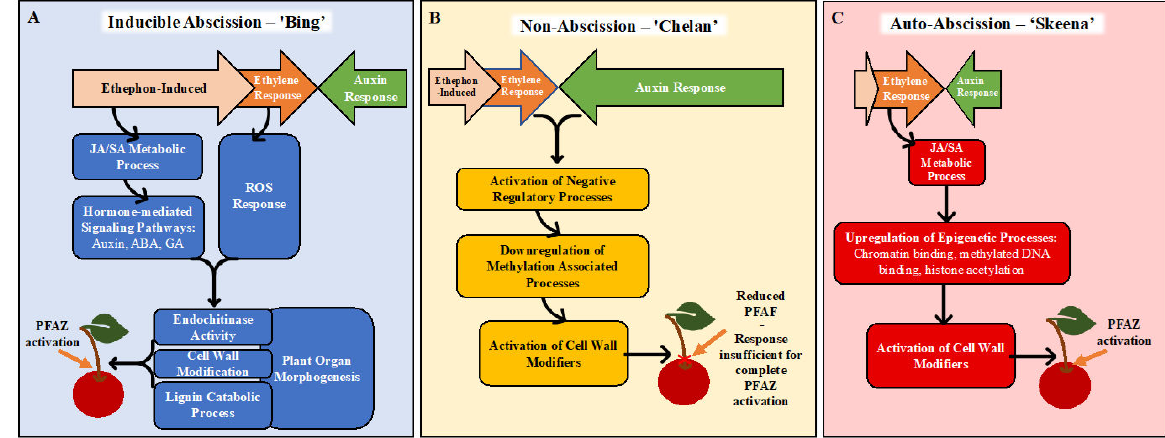
Figure 7. Hypothetical models for abscission, based on gene expression and gene ontology (GO) enrichment results following ethephon application of ‘Bing’, ‘Chelan’, and ‘Skeena’ sweet cherry. In ‘Bing’ ( A ), ethephon offsets the balance between ethylene and auxin in favor of ethylene. This triggers endogenous ethylene-responses that stimulates JA- and SA-mediated signaling, additional hormone-mediated signaling pathways and reactive oxygen species (ROS) responses. Together, these ethylene-induced signaling pathways activate downstream processes associated with morphological changes at the PFAZ, including chitin metabolism, cell wall modification, plant organ morphogenesis, and lignin biosynthesis and deposition. The culmination of these events ultimately facilitates the mechanical separation of the fruit at the PFAZ. In ‘Chelan’ ( B ), the components required for inducible abscission seem to be partially lacking. While ethephon likely contributes to enhanced ethylene signaling, free auxin levels in ‘Chelan’ may be high enough initially to overwhelm any ethylene response, thus limiting the cascade of signaling events leading to abscission. The activation of cell-wall-modifying enzymes may be responsible for the observed reduction in PFRF; however, it does not seem to be enough to facilitate complete PFAZ activation. In ‘Skeena’ ( C ), ethephon does little to affect the overall abscission phenotype, as this cultivar is capable of natural abscission. While ethylene signaling is not high, low initial levels of free auxin may naturally shift the hormonal tug-of-war in favor of abscission, leading to the moderate activation of JA metabolism and signaling. Near the time of harvest, upregulation in processes associated with epigenetic modification, and, ultimately, the activation of cell wall modifiers may represent intermediates in an alternate, ethylene-independent pathway to PFAZ